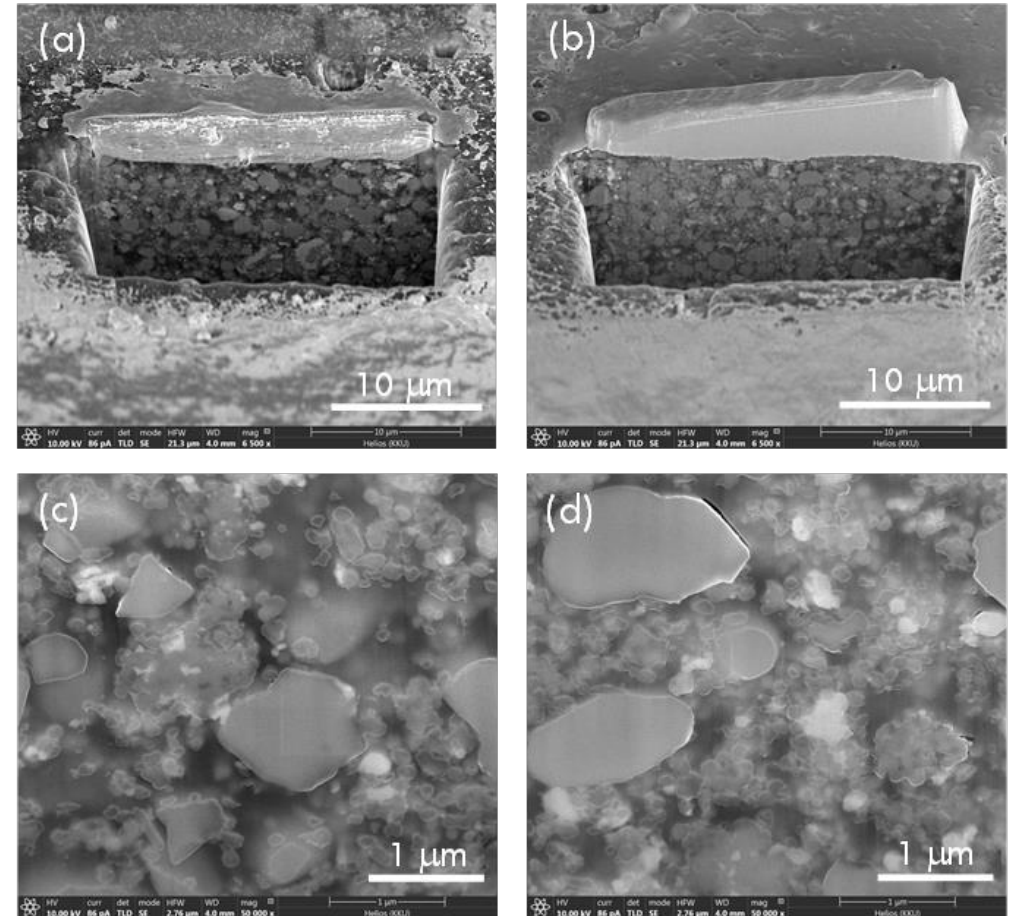
Figure 3. Cross-section images of the Ag- n BT/PVDF-(0.2) μ BT composites with ( a , c ) f Ag-nBT = 0.25 and ( b , d ) f Ag-nBT = 0.30.